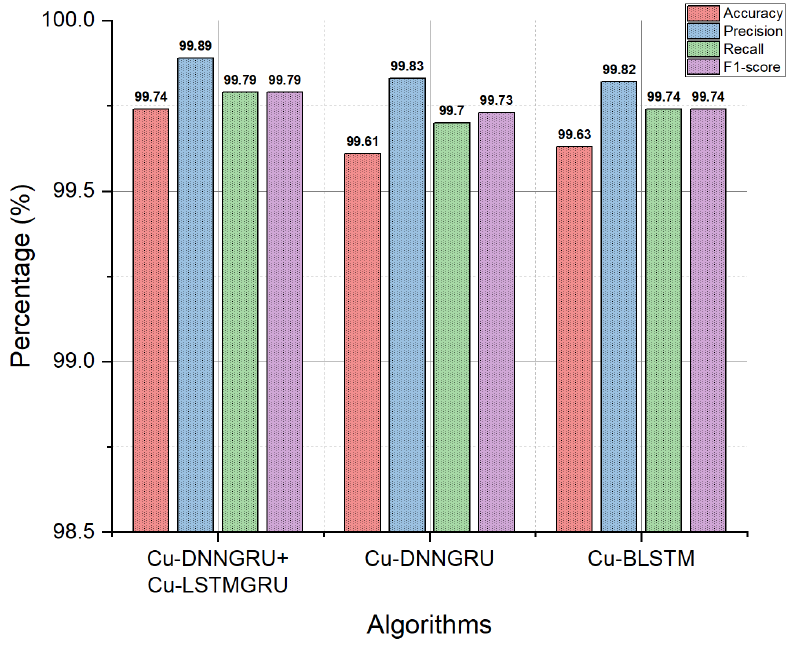
Figure 5. Accuracy, precision, recall and